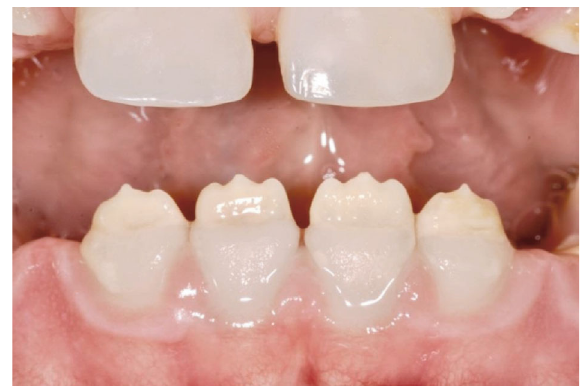
Figure 1: Preoperative view of the lower incisors a ff ected by AI type